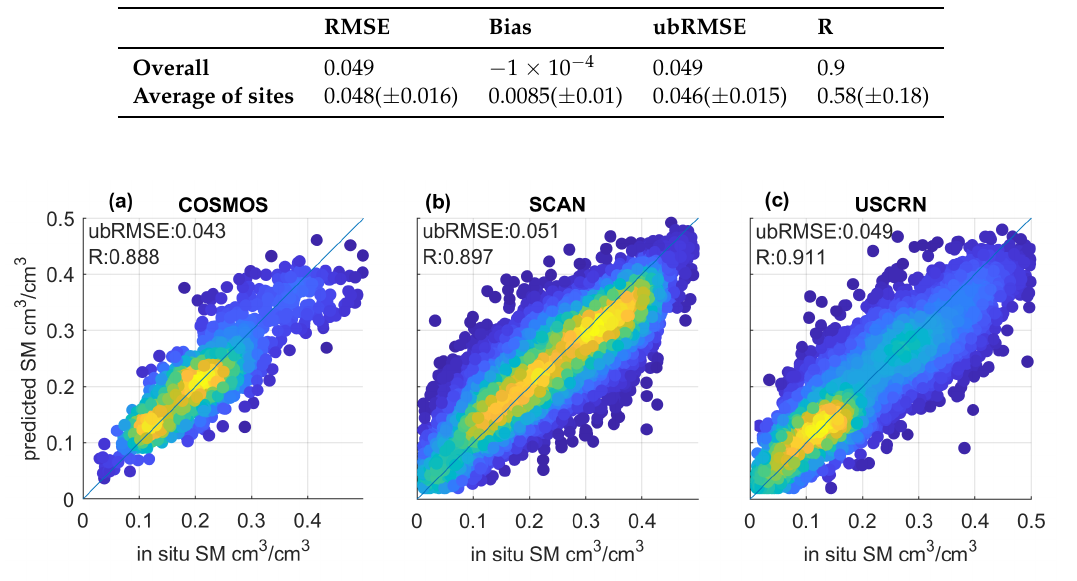
Table 4. Overall and averaged performance metrics for multiple ML models based on SM networks. Numbers in parentheses are the standard deviations of metrics across different network-based models.